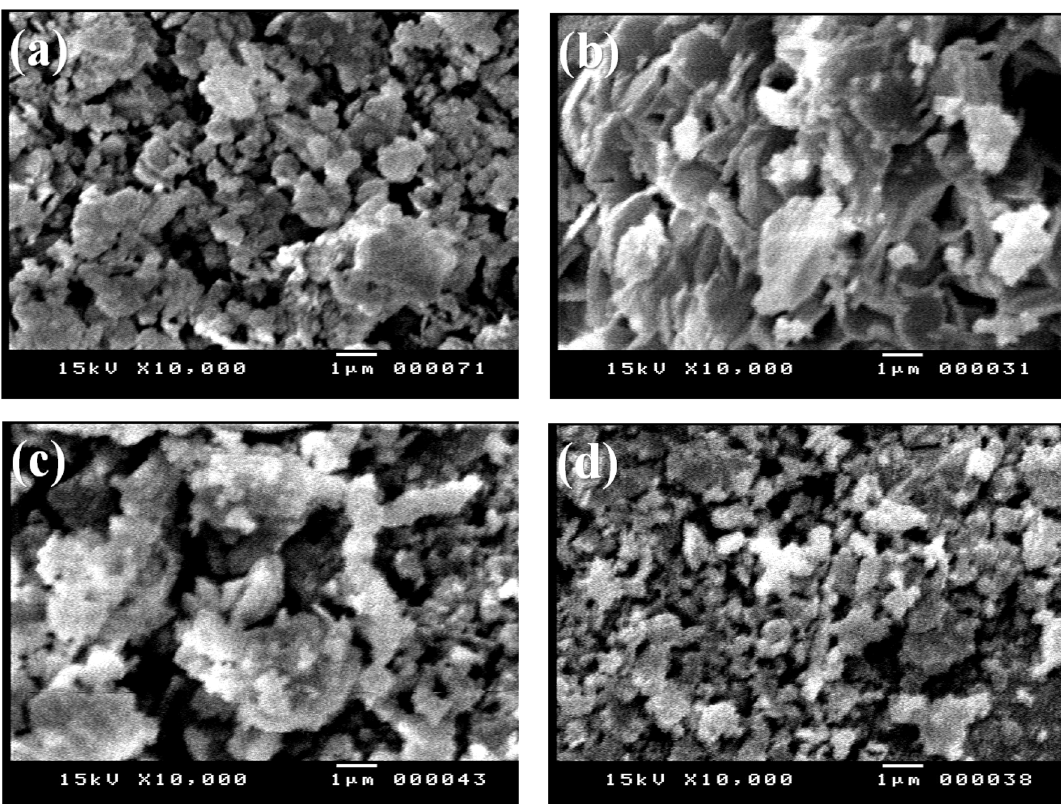
Figure 4. SEM images of ( a ) K400, ( b ) 10% H 2 SO 4 /K400, ( c ) 10% WO 3 /K400, and ( d ) 10% ZrO 2 /K400 catalysts calcined at 400